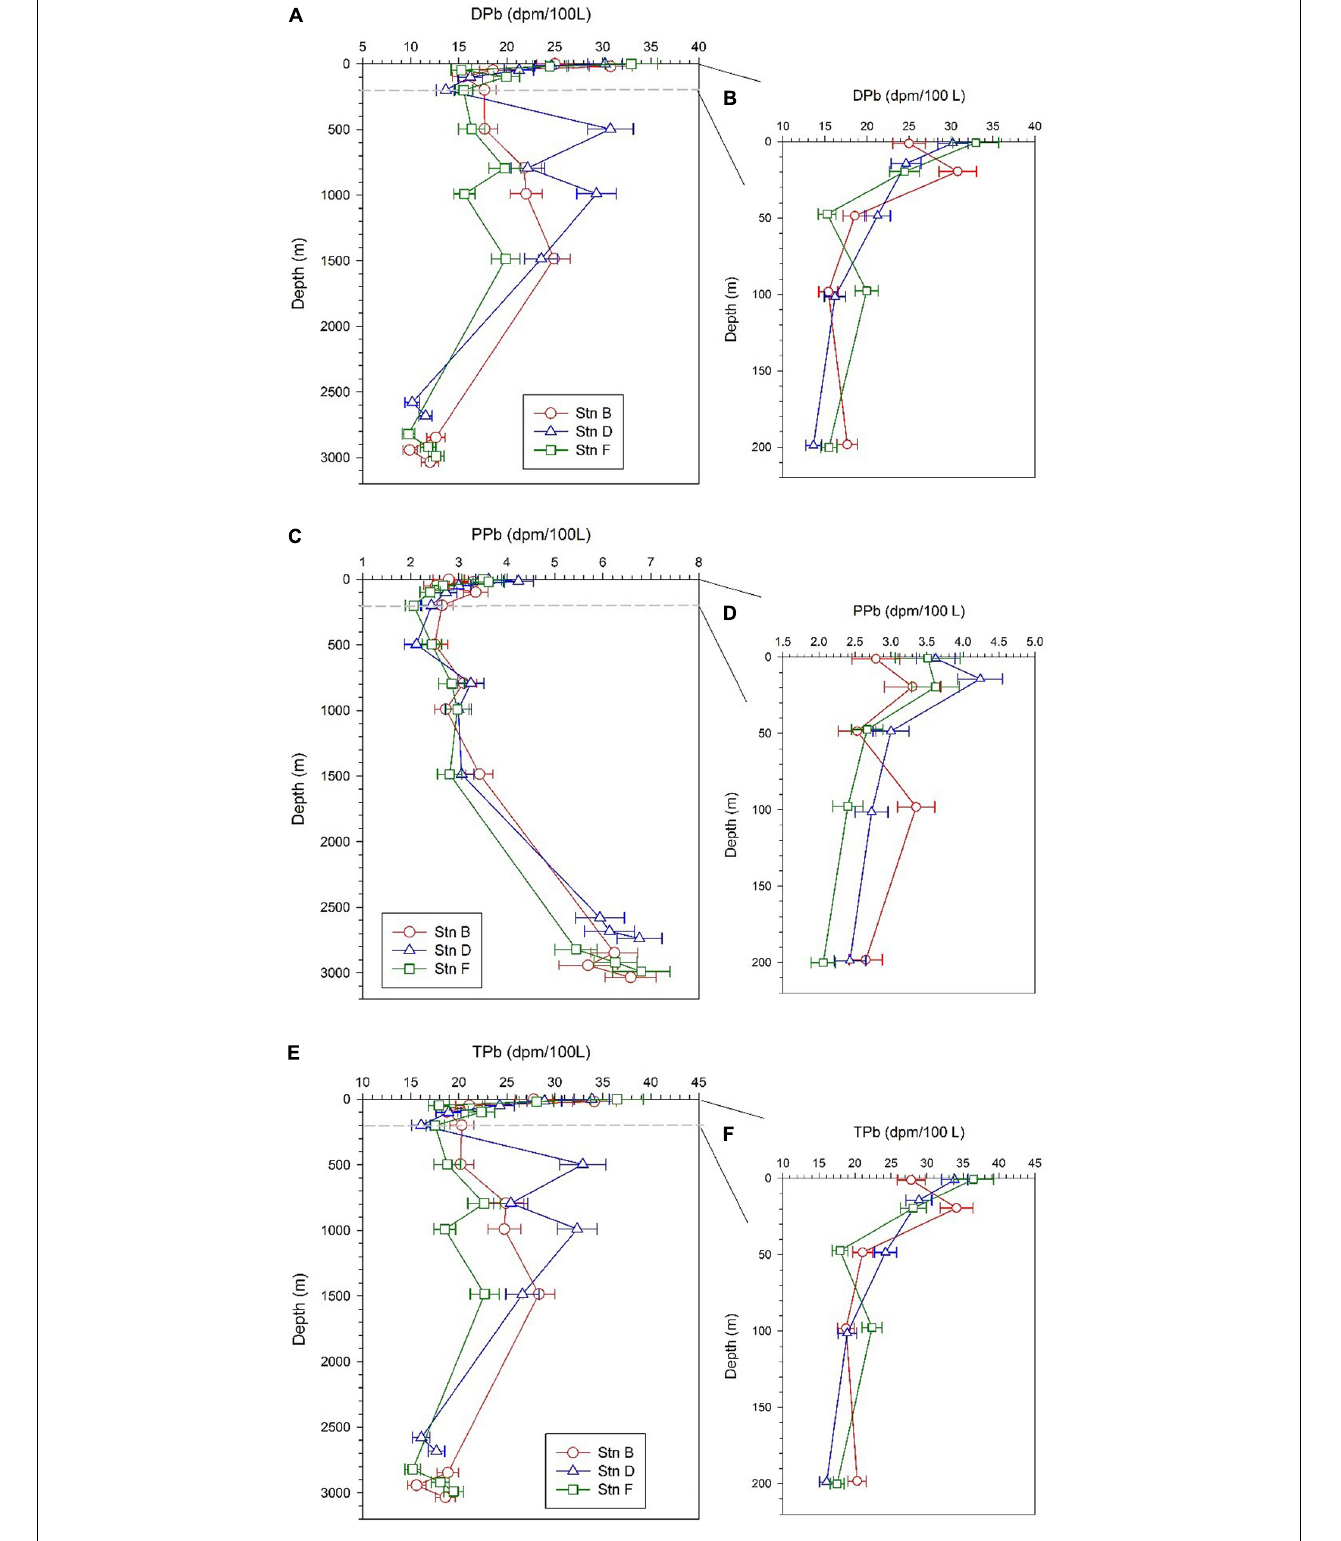
FIGURE 4 | Profiles of dissolved 210 Pb (DPb), particulate 210 Pb (PPb), and total 210 Pb (TPb) at the three sites; panels (A,C,E) are profiles in the full water column; panels (B,D,F) are profiles in the upper 200 m.